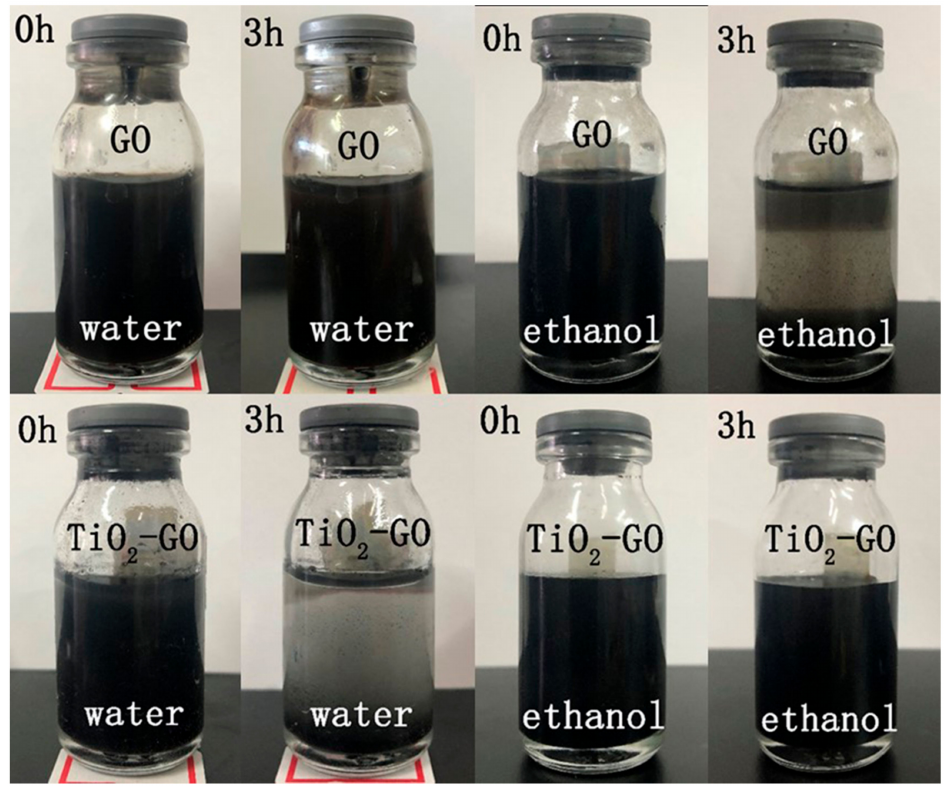
Figure 7. The comparison of TiO 2 –GO and GO suspension in water and ethanol after setting for 1 h and 3 h.